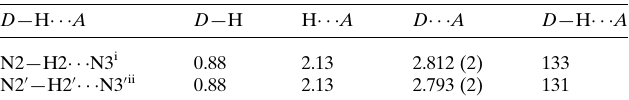
Table 1 Hydrogen-bond geometry (A˚ , (cid:3) ).